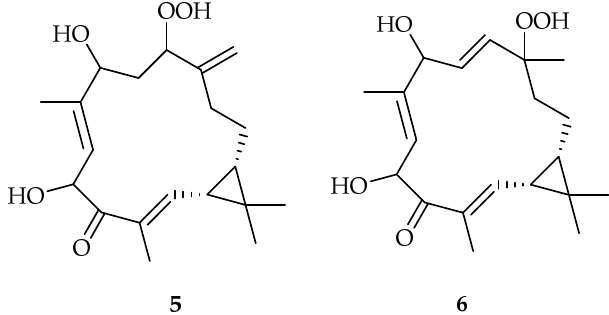
Figure 3. Structures of EBC-304 5 [8] and EBC-320 6 [8].